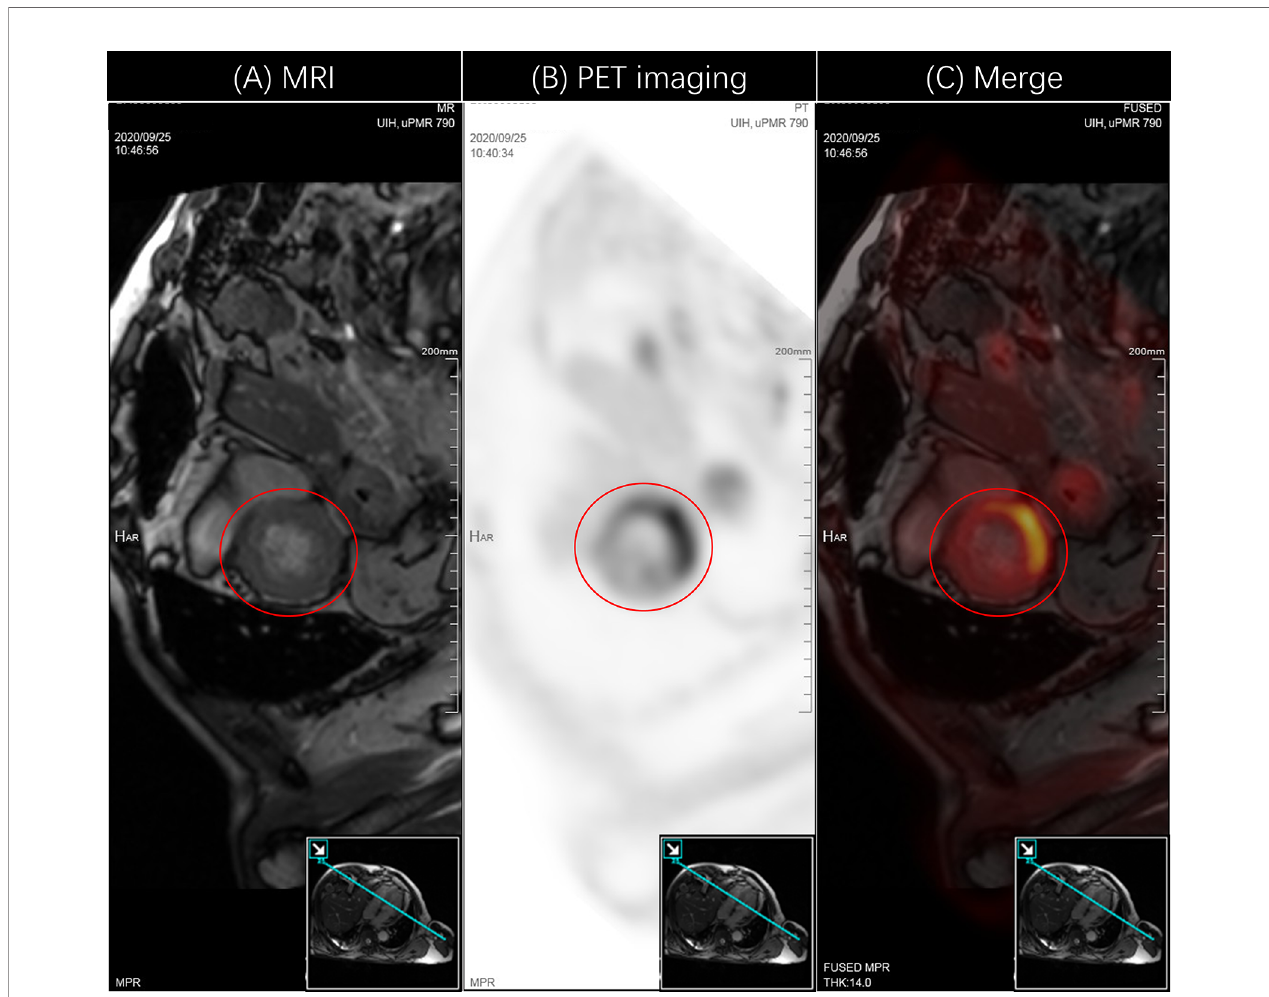
FIGURE 2 | PET-CMR images showed myocardial in fl ammatory damage. (A) MR image indicated the physiological tissue structure of the heart. The red circle represented the left ventricle. The fi gure in the lower right corner was the image cut surface. (B) PET image indicated the uptake of the contrast media 18 F-FDG. The red circle represented the increased intake. (C) Fusion image of PET and MR, which visually displayed myocardial in fl ammatory damage in the left ventricle. PET, positron emission computed tomography; 18 F-FDG, 18 F- fl